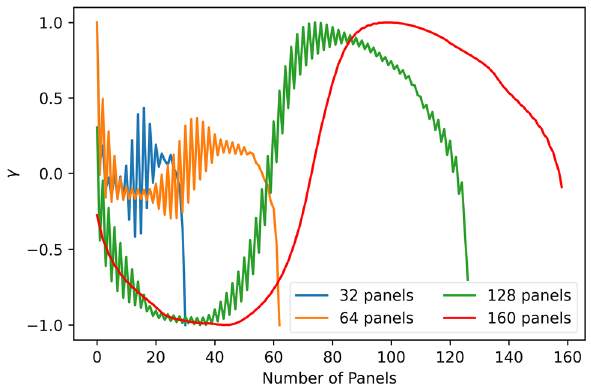
Figure 6. Computed vortex distribution as a function of the number of panels.